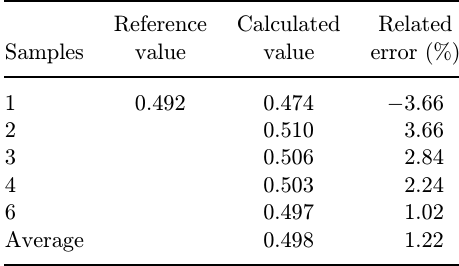
Table 3(b). The results of a random sample of tablet selected to add to the calibration